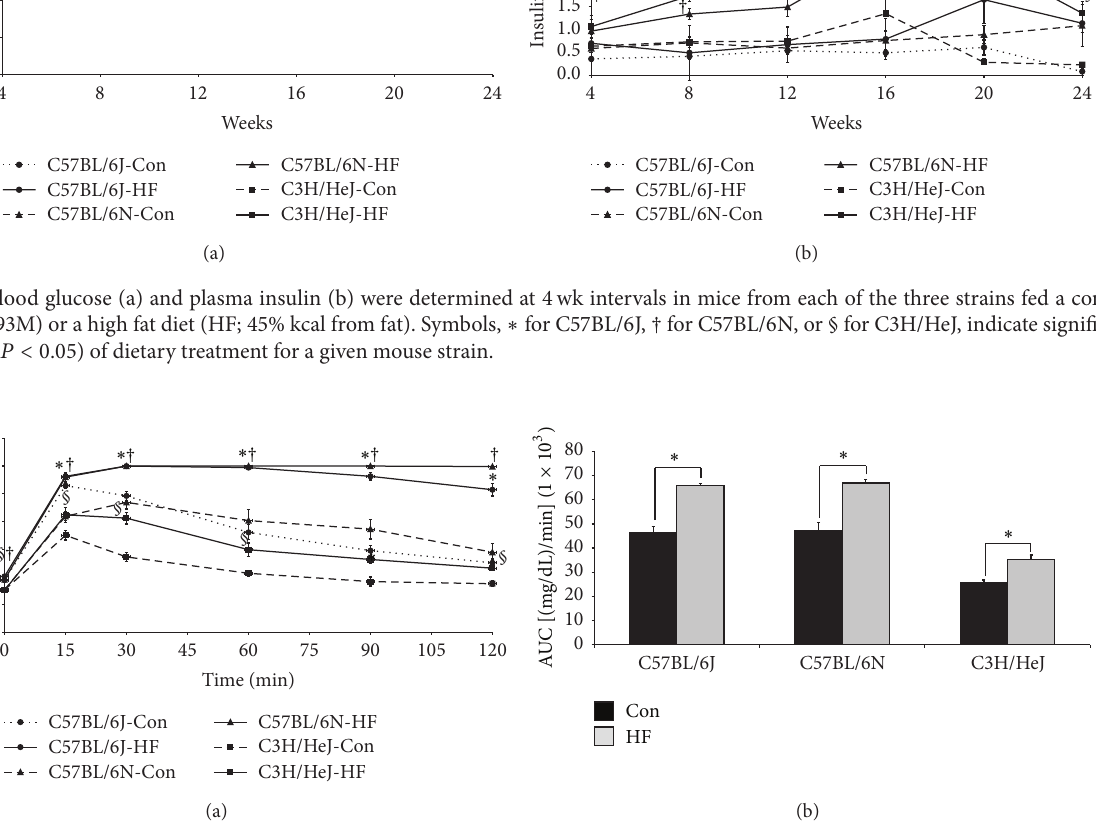
Figure 3: Glucose tolerance test results following 24 wk on control or high fat diet. One week prior to the end of the study, an intraperitoneal glucose tolerance test was administered (2g glucose/kg body weight) in the C57BL/6J, C57BL/6N, and C3H/HeJ mice fed a control (Con; AIN-93M) or a high fat diet (HF; 45% kcal from fat). (a) Tail blood was collected following 15, 30, 60, 90, and 120min following glucose injection and symbols, ∗ for C57BL/6J, † for C57BL/6N, or § C3H/HeJ, indicate significant differences ( 𝑃 < 0.05 ) of dietary treatment for a given mouse strain. (b) Area under the curve (AUC) was calculated for the IGTT and symbol, ∗ , represents a significant difference ( 𝑃 < 0.05 ) between dietary treatments for a given